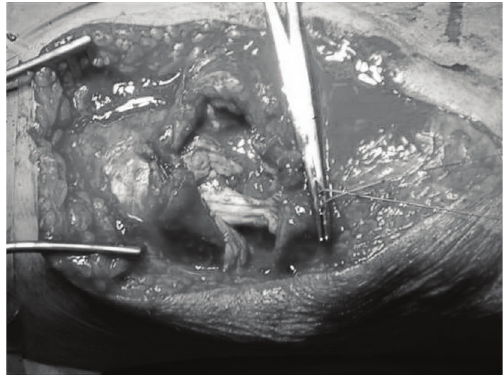
Figure 5: Reconstruction of the partial rupture of the quadriceps tendon in the right knee with nonabsorbable sutures.